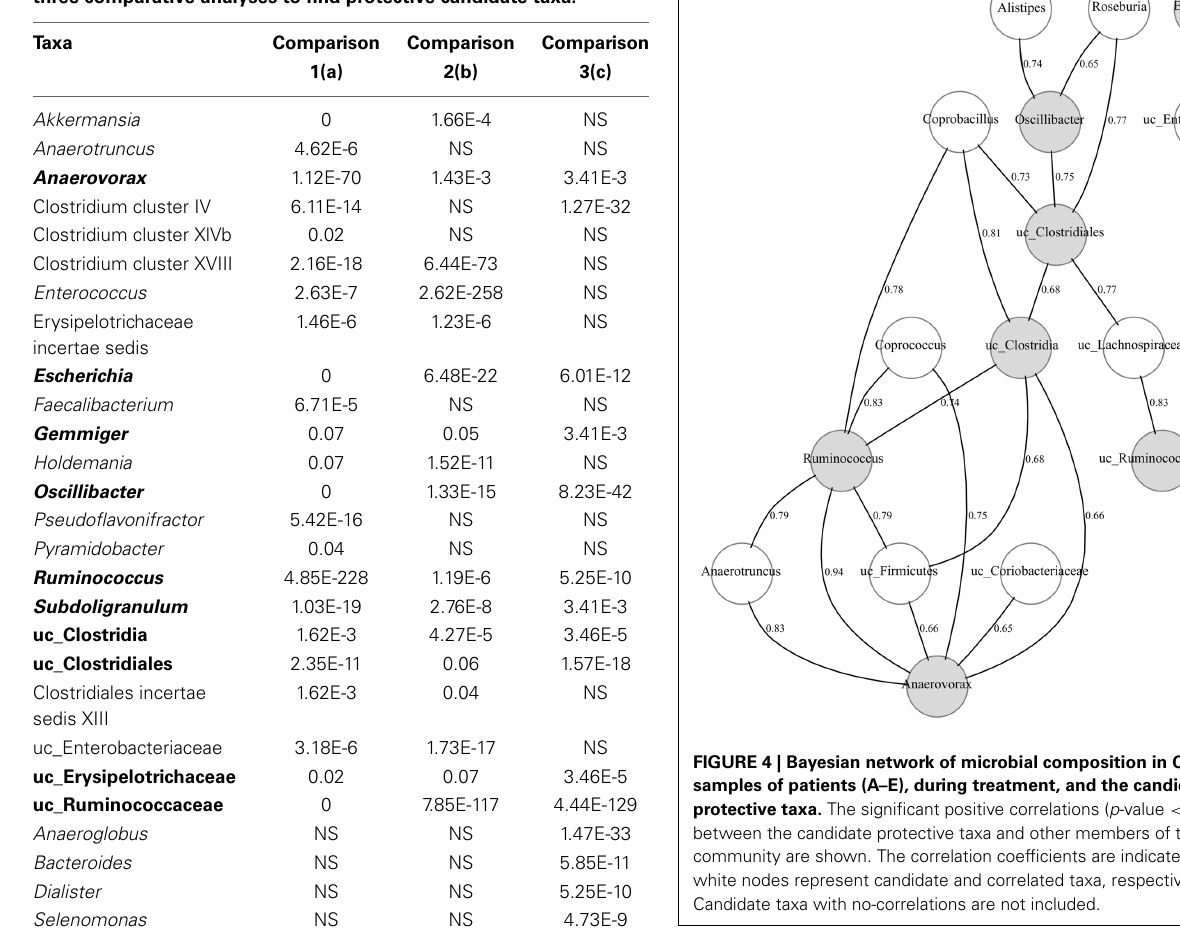
Table 3 | Significant taxa and associated p -value resulting from the three comparative analyses to find protective candidate taxa.